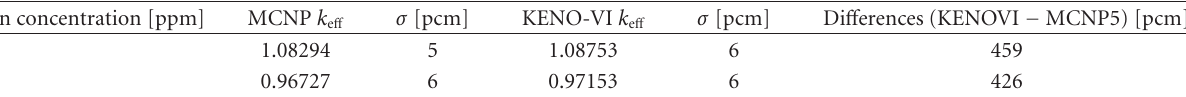
Table 1: Criticality results, CZP in ARI case from KENO-VI and MCNP5